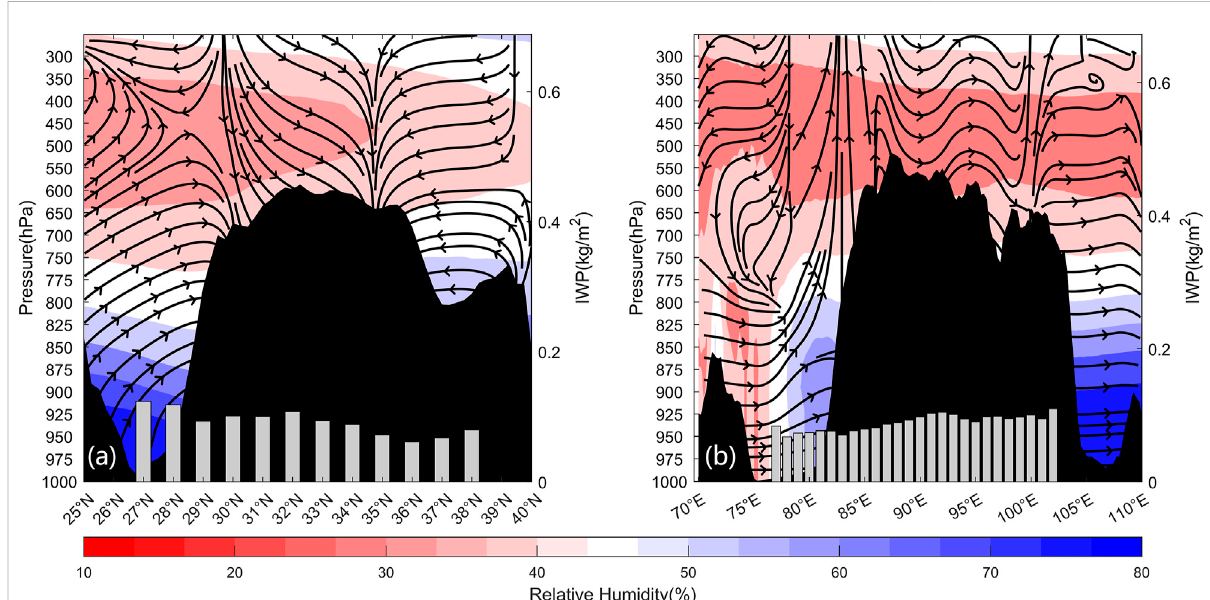
Vertical pro fi le of wind fi eld (stream lines), relative humidity (shaded areas), and topography (black waves) at the domain of 25 ° N – 40 ° N and 70 ° E – 110 ° E from 2003 to 2020. (A) Cross section of 95 ° E; (B) cross section of 30 ° N. The vertical velocity w was enlarged by 100 times because it is 2 – 3 orders of magnitude smaller than the horizontal velocity. The gray bars denote the IWP values at different latitudes and longitudes.